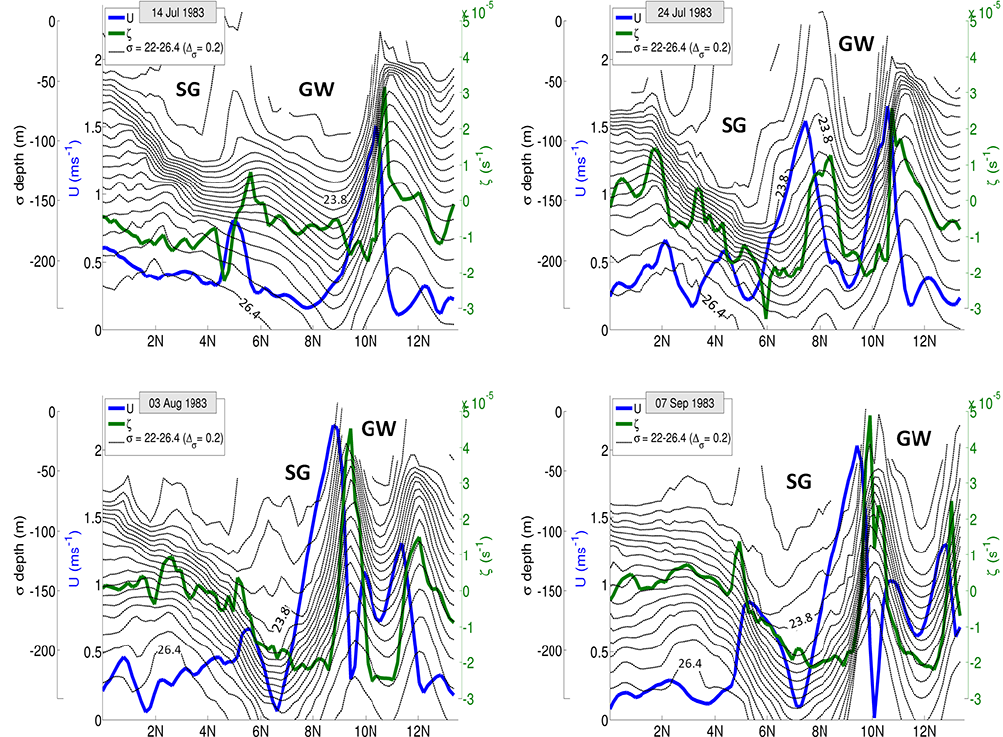
Figure 8. Sequence (corresponding to that of Fig. 5) along an oblique section parallel to the coast (and passing through the Somali eddies as shown on the relative vorticity panel) of: the depths of the isopycnals within the range 22 ≤ σ 0 ≤ 26.4 (black contours by interval of 0.2), the variation of relative vorticity ζ at 50m depth (green curve), and the variation of the current speed U at depth 50m (blue